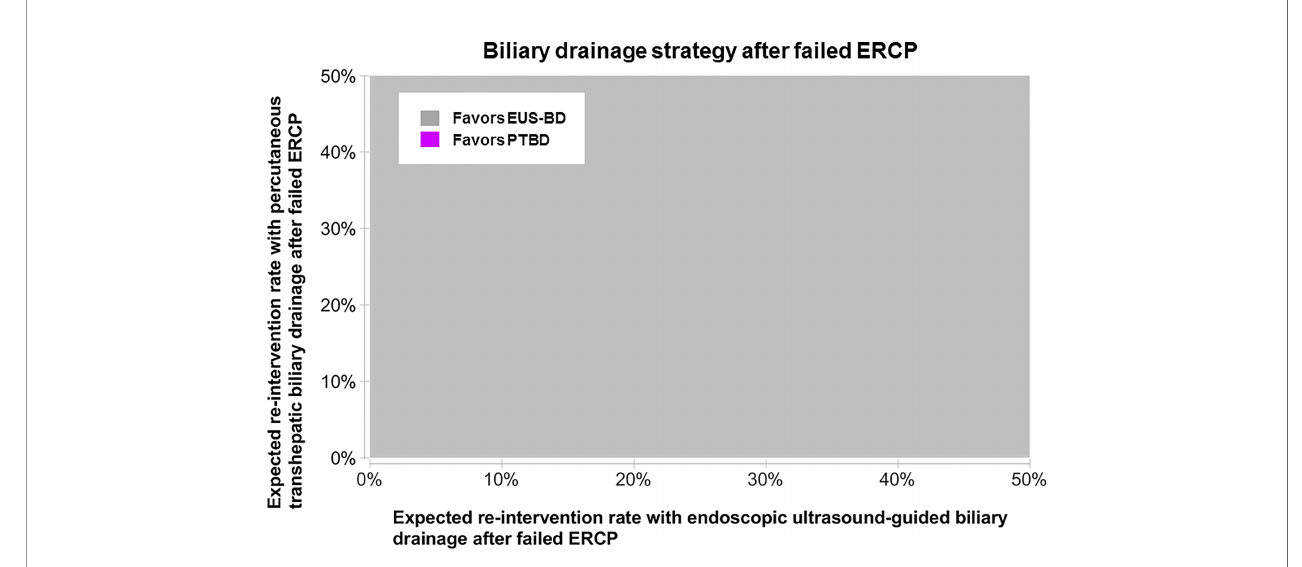
FIGURE 2 | Sensitivity analysis to determine the favored approach on cost-minimization basis depending on the expected re-intervention after EUS-BD or PTBD in a patient who failed ERCP. The concept of this plot is to highlight the preferred strategy at any chosen point along x- and y-axis in color. EUS-BD is favored regardless of the expected re-intervention rate within the evaluated range of 0%-50% for either procedure, due to the extent of cost-savings with EUS-BD compared to PTBD. EUS-BD, endoscopic ultrasound-guided biliary drainage; PTBD, percutaneous transhepatic biliary drainage; ERCP, endoscopic retrograde